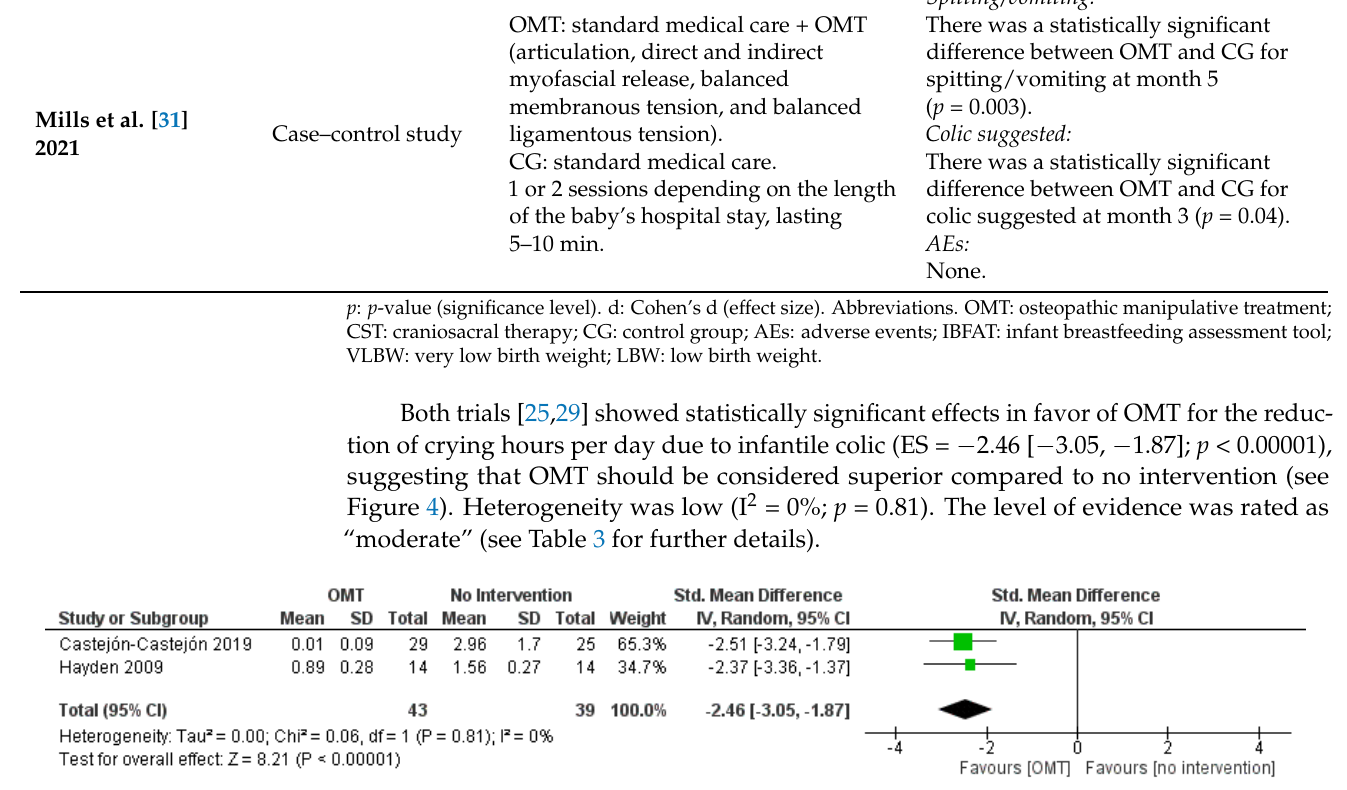
Figure 4. Forest plot comparing the effects of OMT vs. no intervention for hours of crying per day due to infantile colic in term infants.